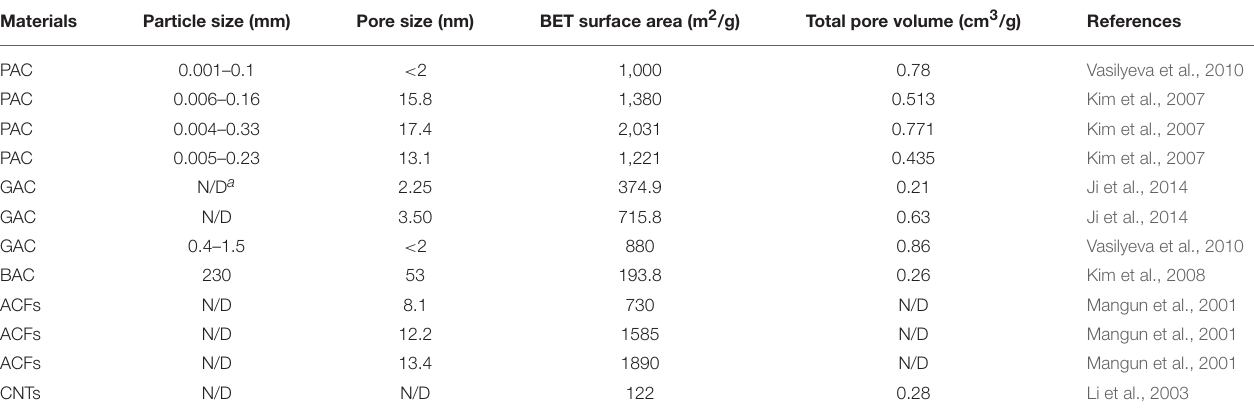
TABLE 1 | Physical properties of the selected activated carbon in this paper.